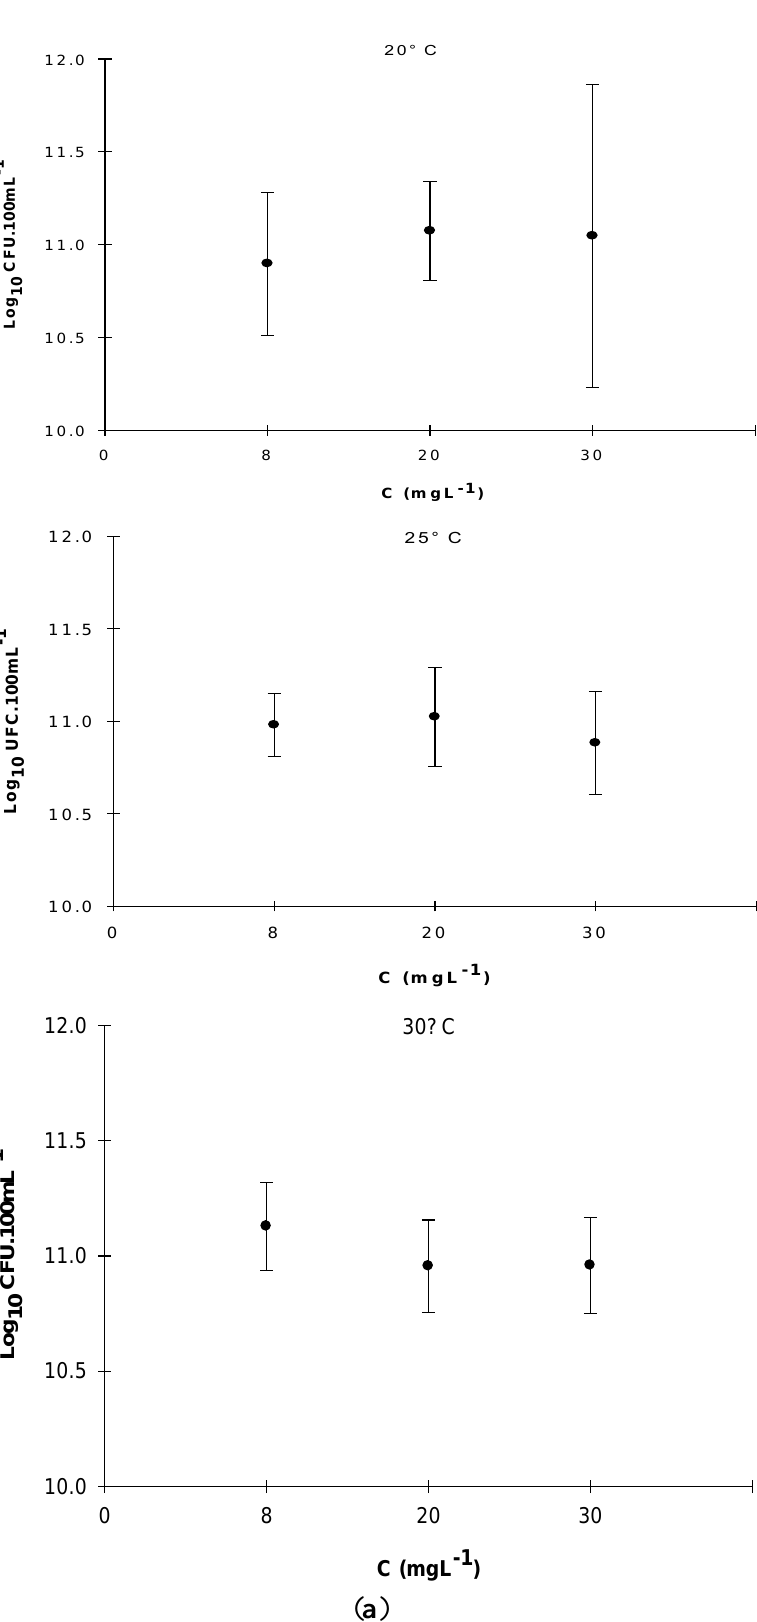
Figure 2. Standard deviations observed in resistance tests that used temperature and disinfectant dose as variables. C = concentration (mg·L −1 ) ( a ) T = 0 min; ( b ) T = 15 min; ( c ) T = 30